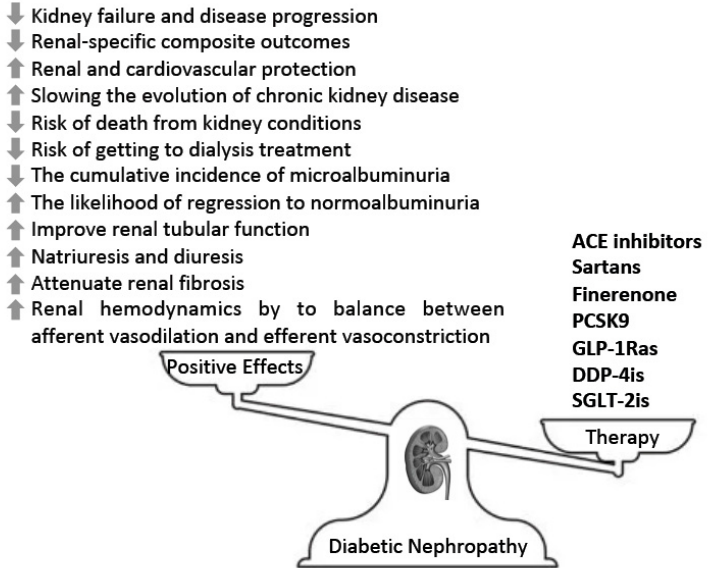
Figure 2. Main effects of traditional and innovative therapies on diabetic nephropathy. ACE, angiotensin converting enzyme; DPP-4is, dipeptidyl peptidase 4 inhibitors; GLP-1 Ras, glucagon-like peptide-1 receptor agonists; PCSK9, proprotein convertase subtilisin/kexin type 9; SGLT-2is, sodium glucose cotransporter 2 inhibitors.